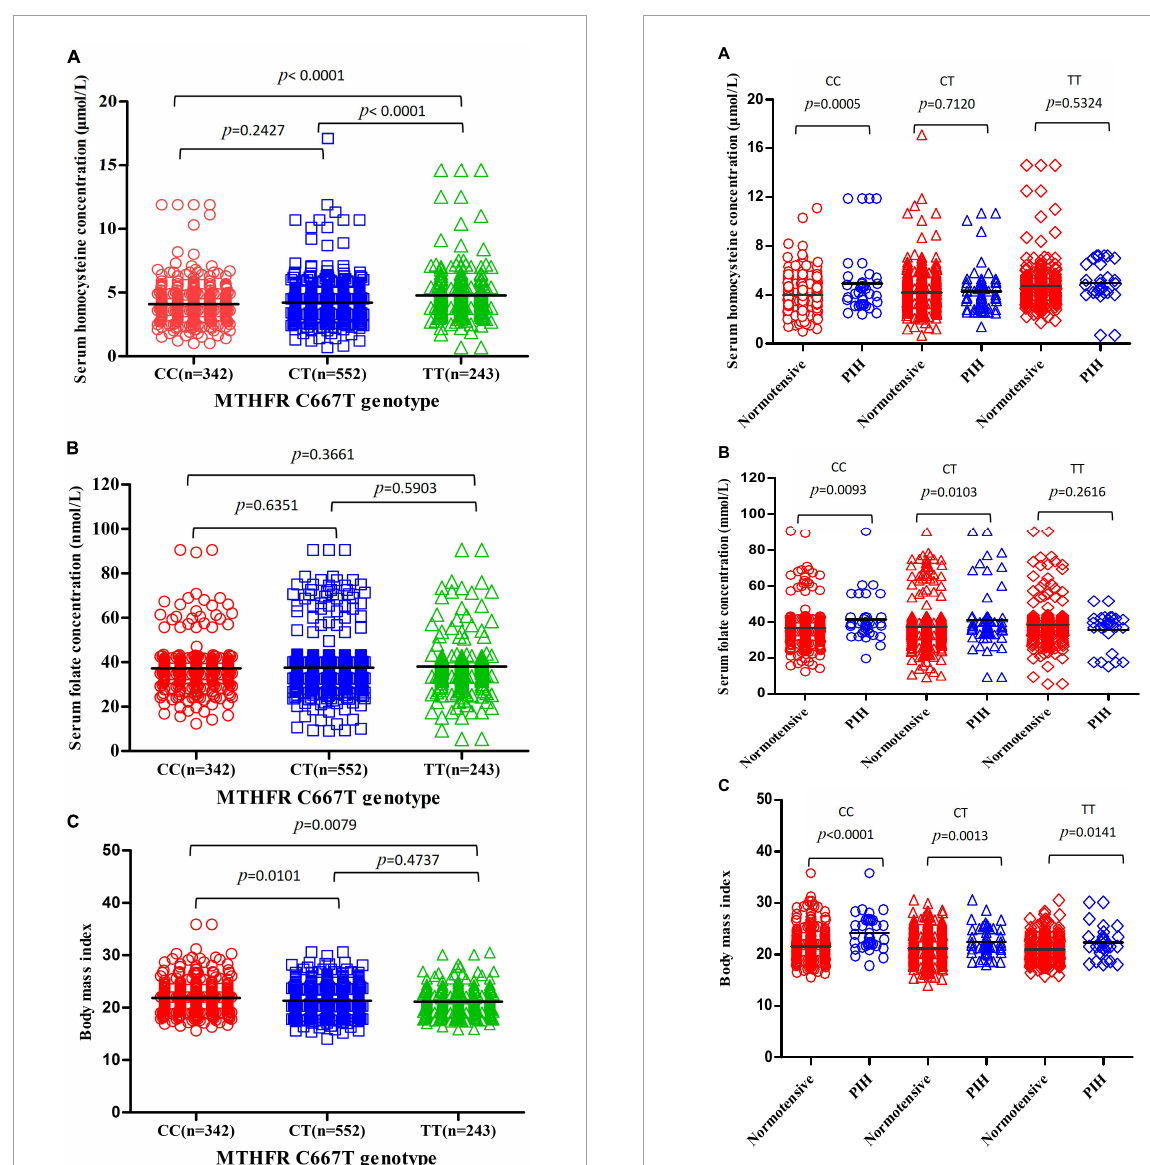
FIGURE2 Association between MTHFR C677T genotype and serum homocysteine concentration, serum folate concentration, and BMI. (A) Association between MTHFR C677T genotype and serum homocysteine concentration. (B) Association between MTHFR C677T genotype and serum folate concentration. (C) Association between MTHFR C677T genotype and BMI.